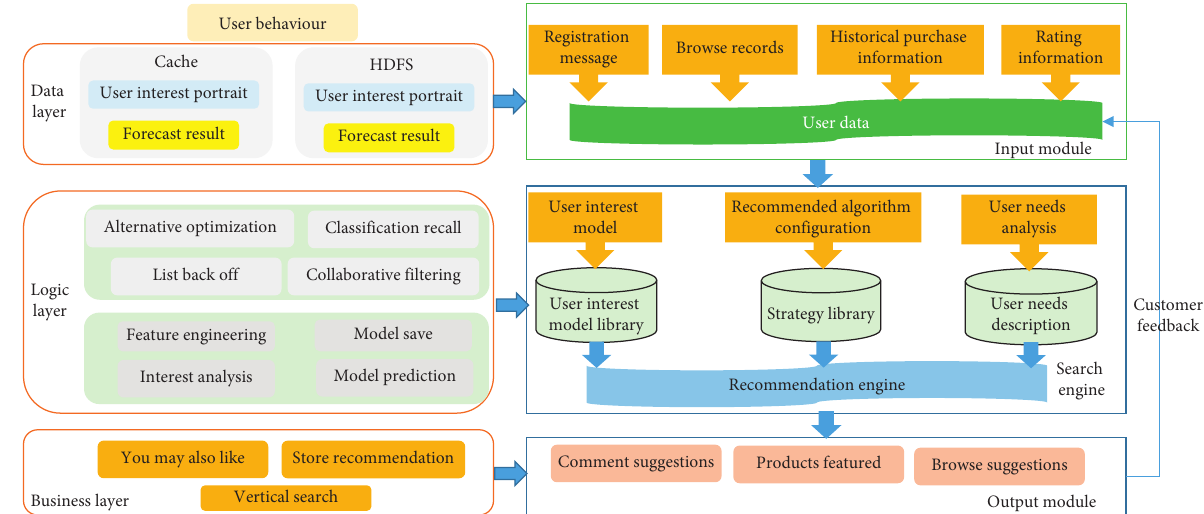
Figure 1: Structure diagram of the personalized recommendation system.